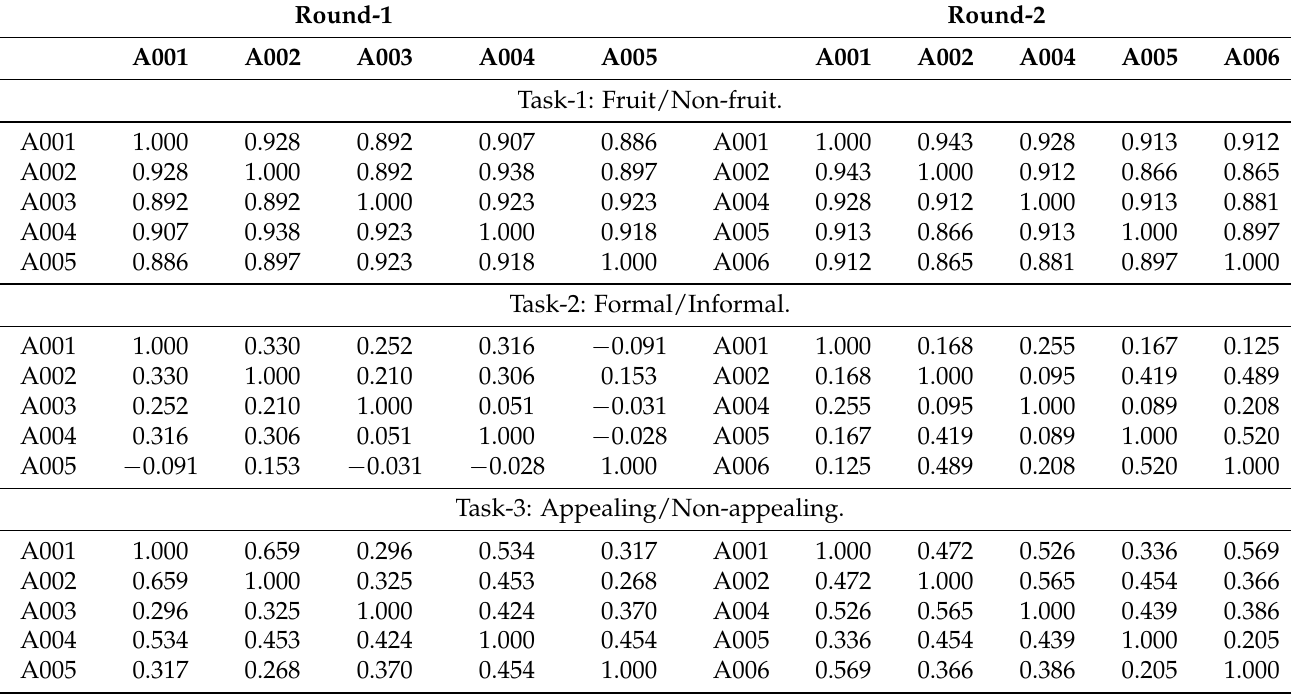
Table 2. Inter-annotator agreement for Round-1 and Round-2 annotation.